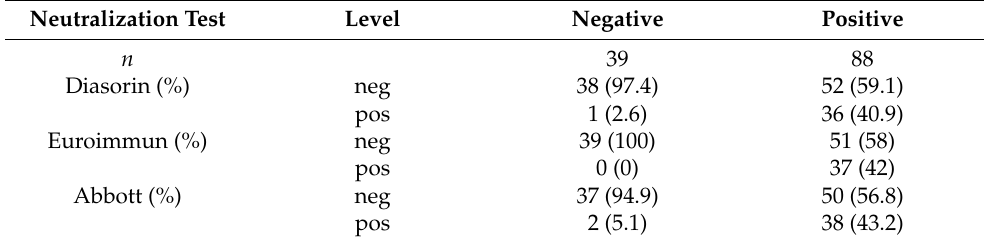
Table 3. Cross table NT results versus 3 different